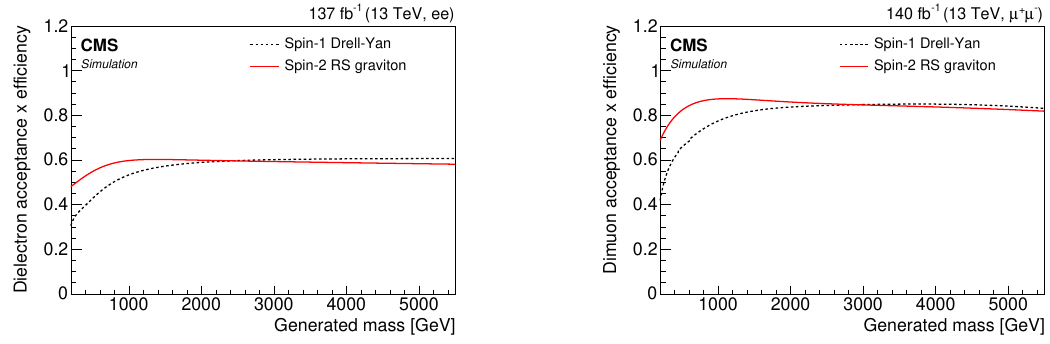
Figure 1 . Product of the acceptance and the efficiency for (left) dielectron and (right) dimuon pairs as a function of generated mass in simulated events. The DY samples are used to represent spin-1 particles, and RS graviton samples are used for spin-2